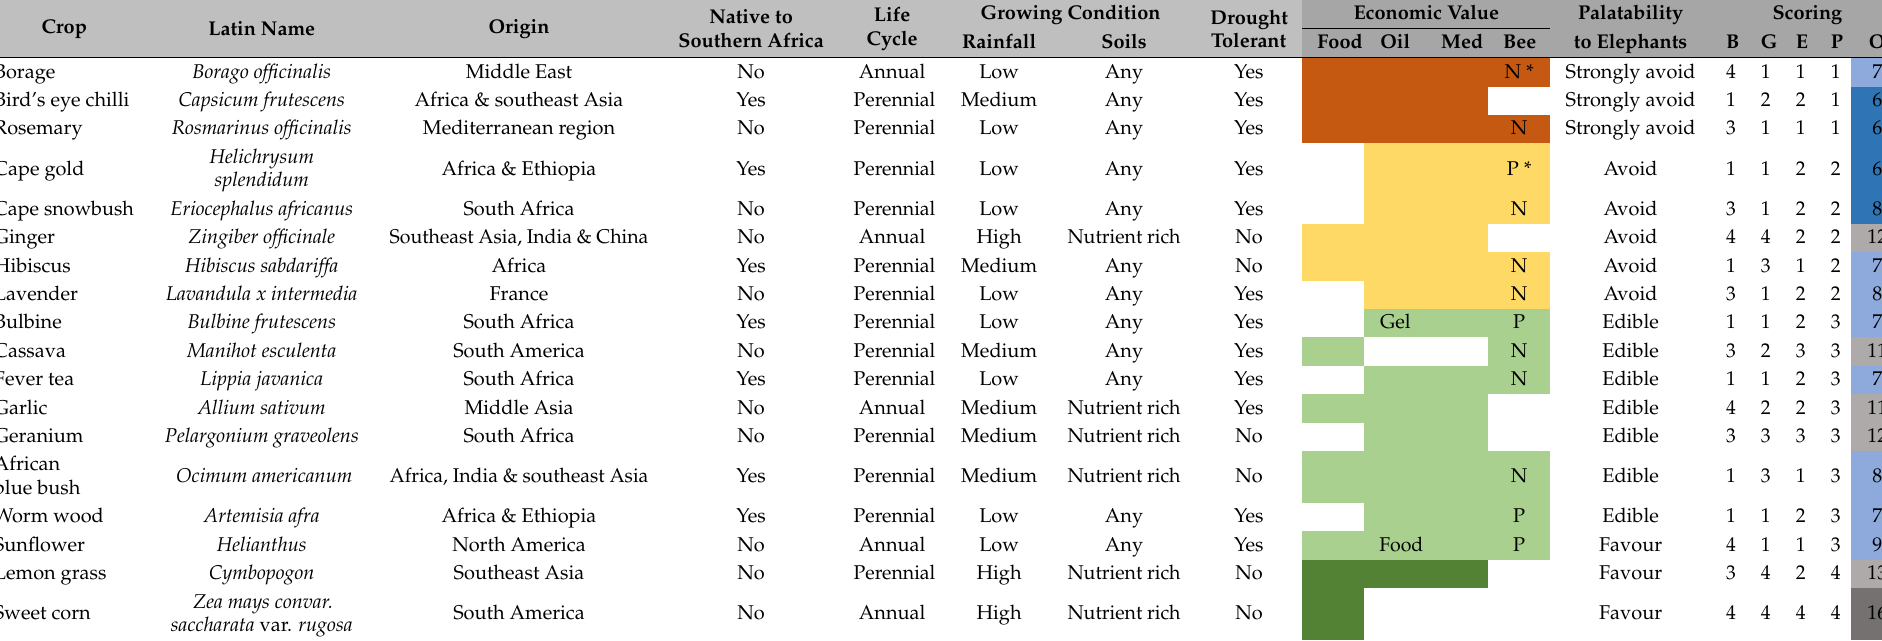
Table 2. The 18 plant types that were included in the cafeteria-type experiments. Their broad life cycle characteristics (B) were scored, while their growth requirements (G) and their economic value (E) were based on information available in the literature. Their palatability scoring was derived from the electivity indices of the elephants during the cafeteria experimental setup (P). The score for each category was based on the reasoning explained in Table 1. The colours under the economic value correspond with those of Figure 6 with rust representing the strongly avoided plants, yellow those that were avoided, light green those that were edible and dark green those that were